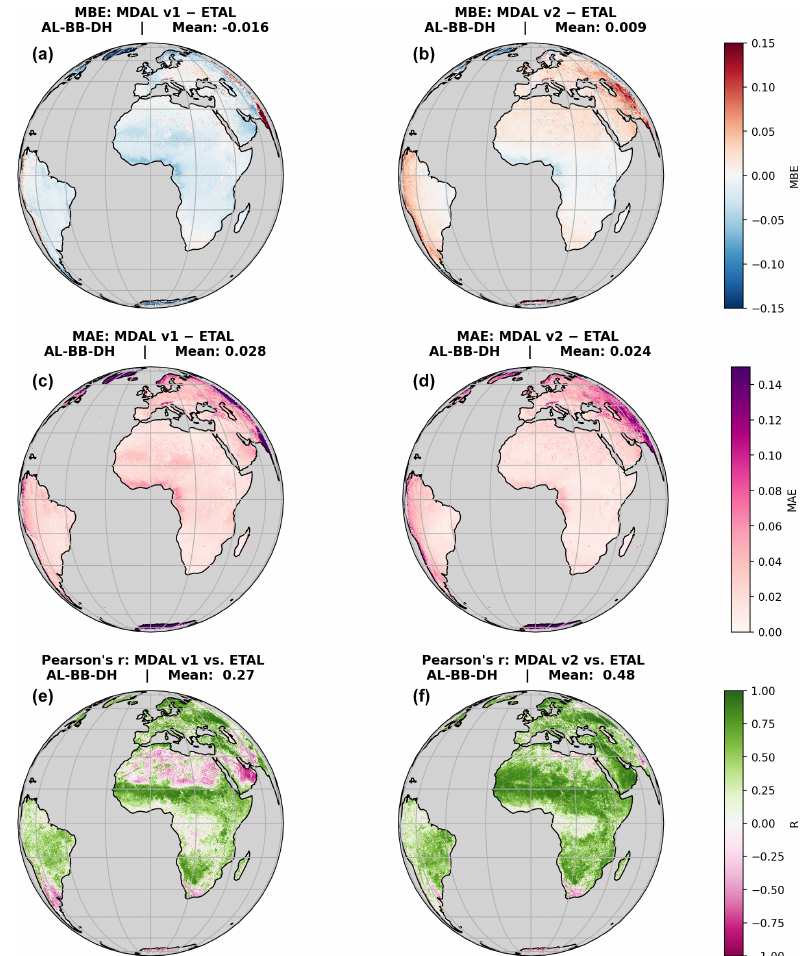
Figure A1. Plots showing performance of MDAL v1 and v2 against ETAL for all pixels, for AL-BB-DH and analysis over 1 full year, from